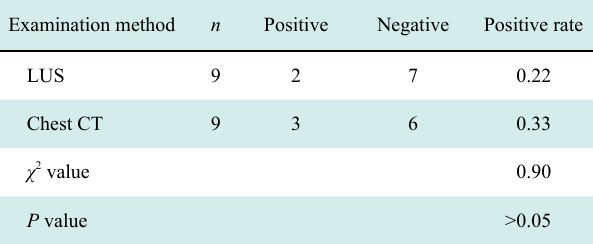
Table 1 Comparison of the positive diagnosis rate on LUS and chest CT of COVID-19